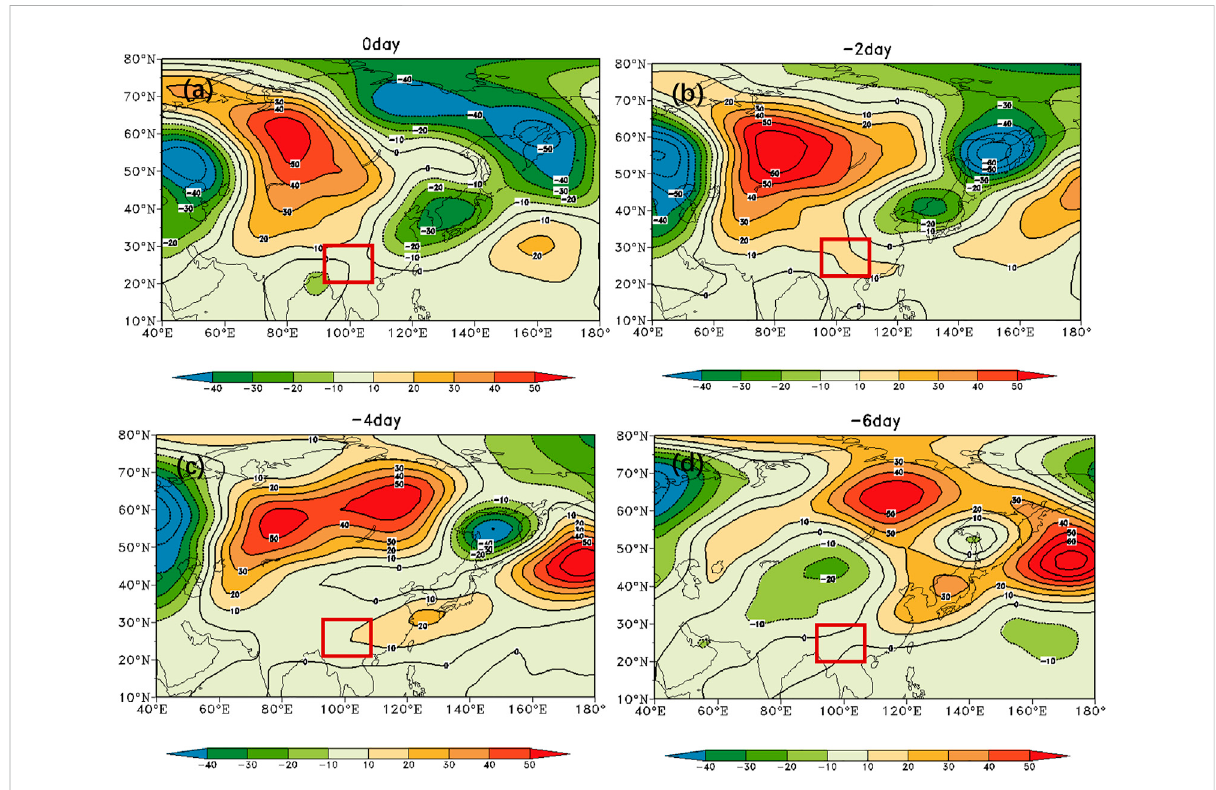
FIGURE 11 Evolution of the low-frequency (15 – 30 days) geopotential height anomaly at 500 hPa from 6 days before the precipitation to 0 day after onset in Yunnan region, unit: